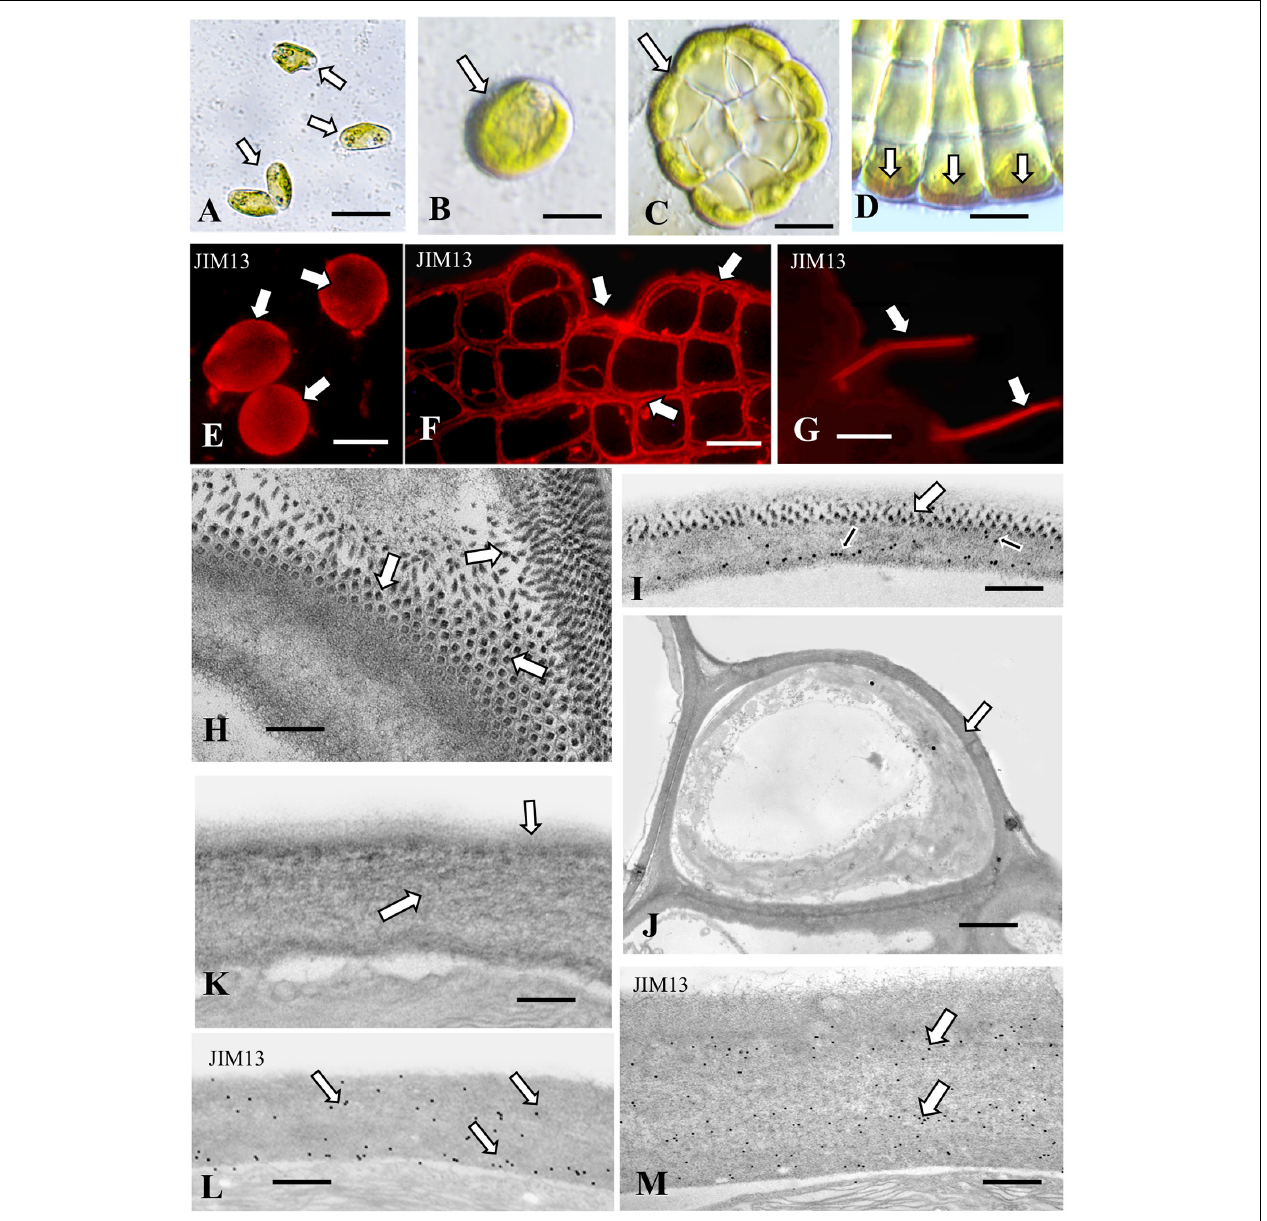
FIGURE 6 | Coleochaete : (A) Zoospores (arrows) that have adhered to the substrate. Bar 5 µ m. (B) Vegetative cell (arrow) after zoospore settling and cell wall production. Bar 8 µ m. (C) 96 h old vegetative multicellular thallus (arrow). Bar 12 µ m. (D) Yariv reagent labeling of cell walls (arrows) at the periphery of the vegetative thallus. Bar 10 µ m. (E) JIM13 labeling of zoospore cell walls (arrows). Bar 8 µ m. (F) JIM13 labeling of the vegetative thallus (arrows). Bar 10 µ m. (G) JIM13 labeling of the hairs (arrows) that emerge from the thallus. Bar 10 µ m. (H) TEM view of the zoospore cell wall surface. Note the ordered packing of projections (arrows). Bar 300 nm. (I) JIM13 labeling of the zoospore cell wall. Labeling is found throughout the wall (arrows). Large arrows show the projection found in the outside of the cell wall of young Coleochaete . Small arrows represent JIM13. Bar 1 µ m. (J) TEM image of an outer vegetative cell. Note the thick cell wall (arrow). Bar 2.25 µ m. (K) TEM image of the vegetative cell wall. An inner wall layer of tightly packed fibers (large arrow) subtends a thin layer of fibrils (small arrow). Bar 450 nm. (L) JIM13 labeling of the cell wall of a vegetative cell. Note the labeling through the wall (arrows). Bar 500 nm. (M) JIM13 labeling of the hair cell wall. Bar 300